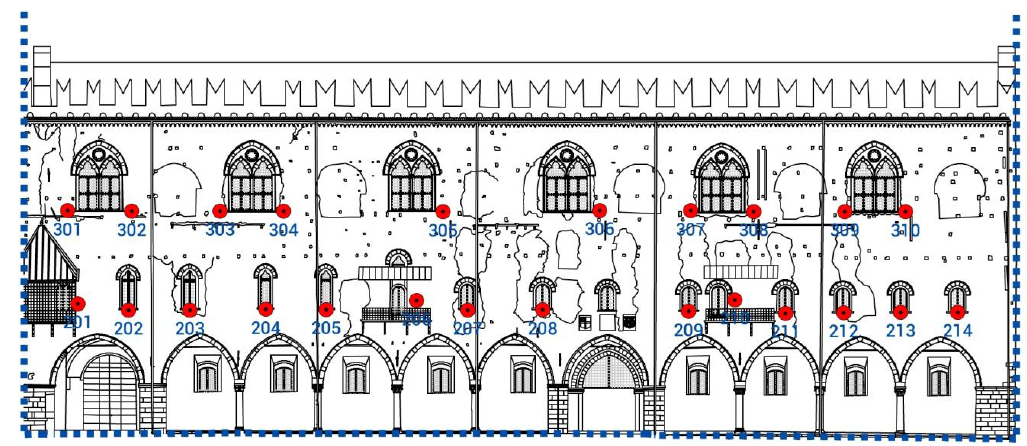
Figure 12. Individuation of the points of detail detected with Total Station on the Palazzo del Capitano façade overlooking Piazza Sordello